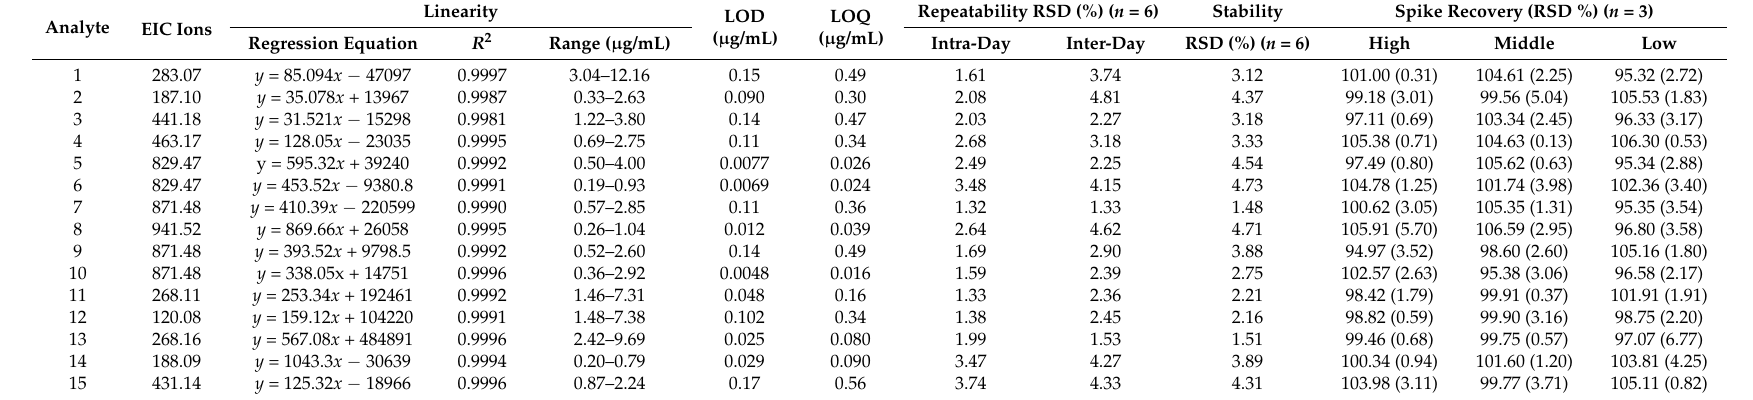
Table 2. The calibration curves, linear ranges, limits of detection (LOD), limits of quantification (LOQ), precision, stability and accuracy of 18 analytes.